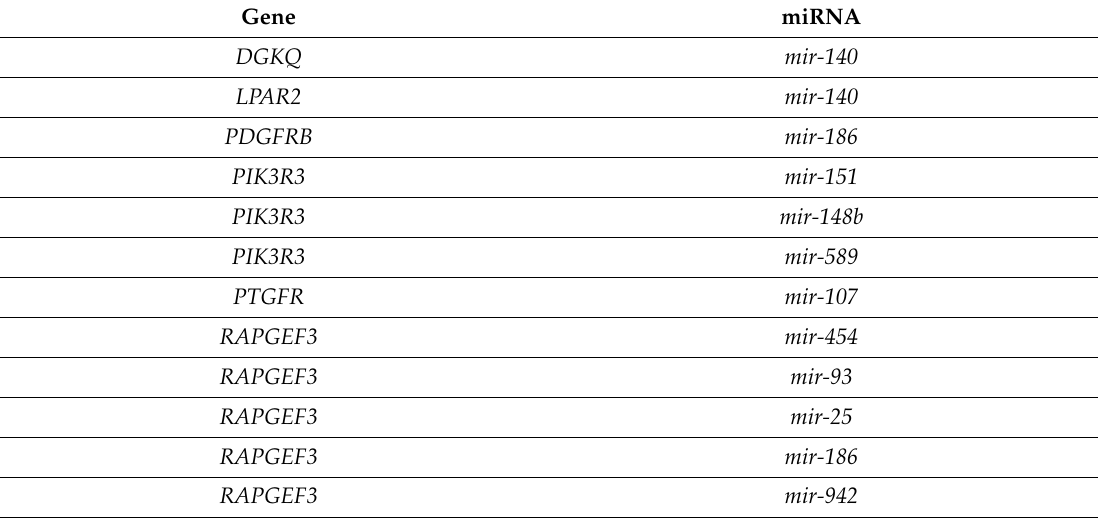
Table 5. A list of miRNAs targeted six genes involved in phospholipase D signaling